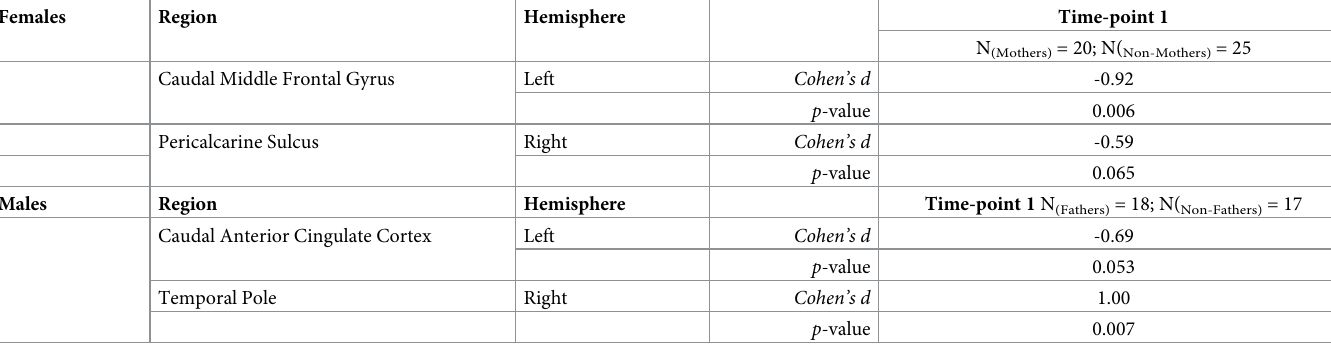
Table 3. Cortical thickness differences between parents (one child) and non-parents for males and females.